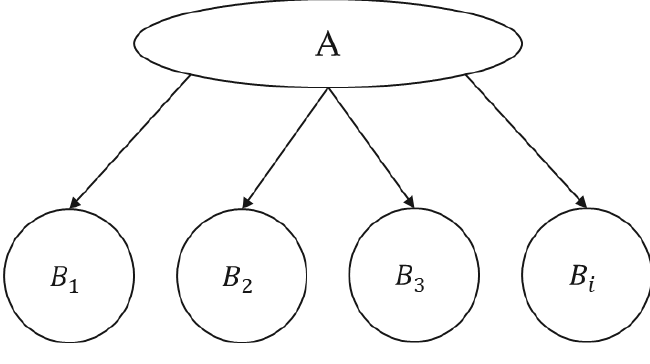
Figure 3. A Naïve Bayes Classifier Network.